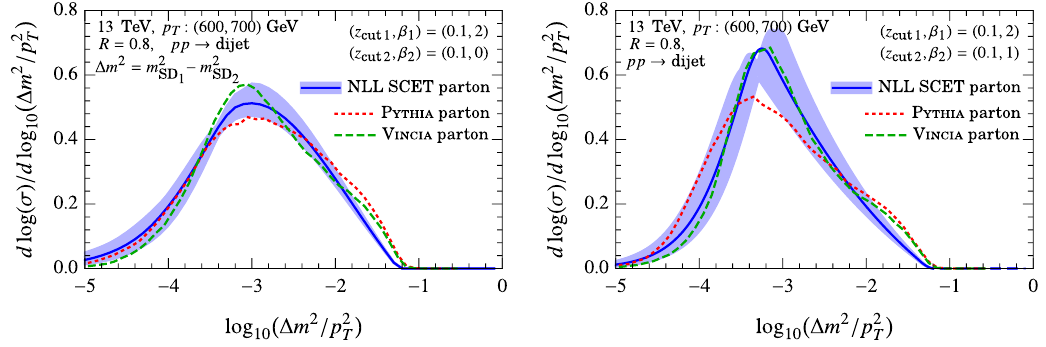
Figure 15 . More Collinear Drop distributions with ( z cut1 ; (cid:12) 1 ) = (0 : 1 ; 2) and ( z cut2 ; (cid:12) 2 ) = (0 : 1 ; 0) (left panel) and ( z cut1 ; (cid:12) 1 ) = (0 : 1 ; 2) and ( z cut2 ; (cid:12) 2 ) = (0 : 1 ; 1) (right panel) from Pythia and Vincia simulations as well as SCET